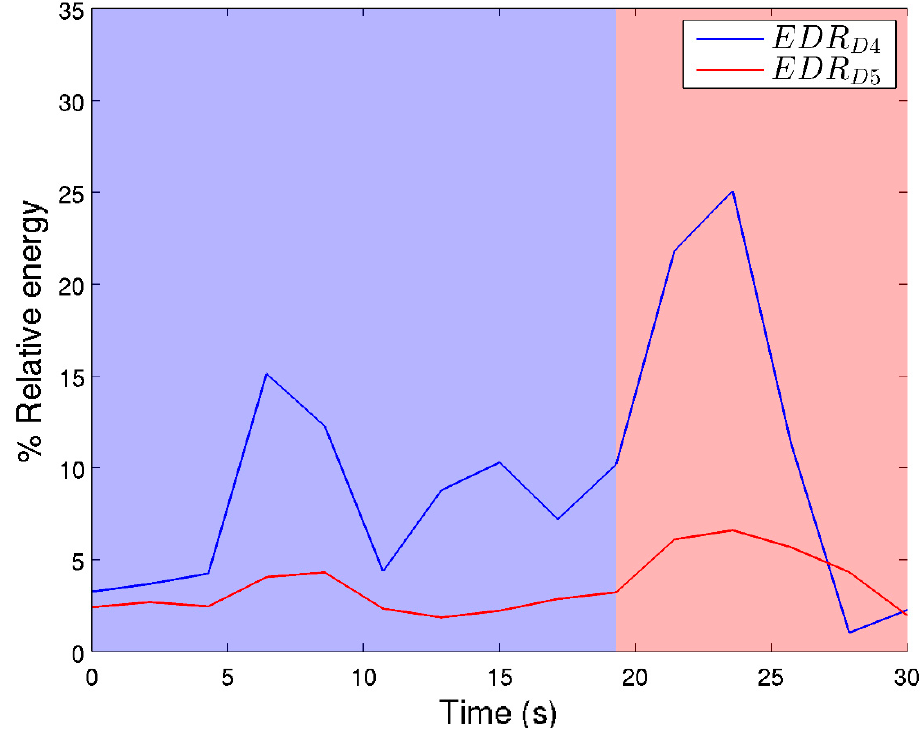
Figure 5. Fatigue detection from inertial data. The figure shows the energy of the subbands corresponding to the detailed DWT coefficients at levels 4 and 5. Red shaded part of the figure indicates the fatigue starting point at second 19.